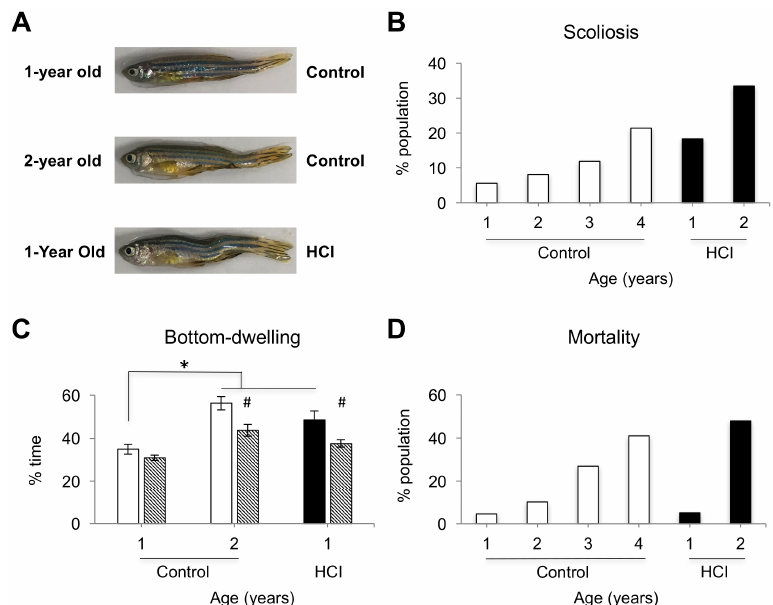
Figure 1. Premature aging phenotype in high caloric intake (HCI) zebrafish: anatomical and behavioral changes, and increased mortality. ( A ) Images of 1-year old Control, 2-year old Control and 1-year old HCI fish with scoliosis. ( B ) Percent of fish with scoliosis within each condition; white bar—Control fish, 1–4 years of age, black bar—HCI fish, 1–2 years of age. ( C ) Bottom-dwelling, time spent swimming at the bottom third of the tank, following no treatment (solid bar) or after Diazepam administration (diagonal stripes), n = 6–8 fish per group, mean ± SEM, * p < 0.05 vs. 1-year old Control; # p < 0.05 Diazepam vs. no treatment. ( D ) Mortality rate in 1–4 year old Control and 1–2 year old HCI fish (see Section 4.1. for the size of each population).